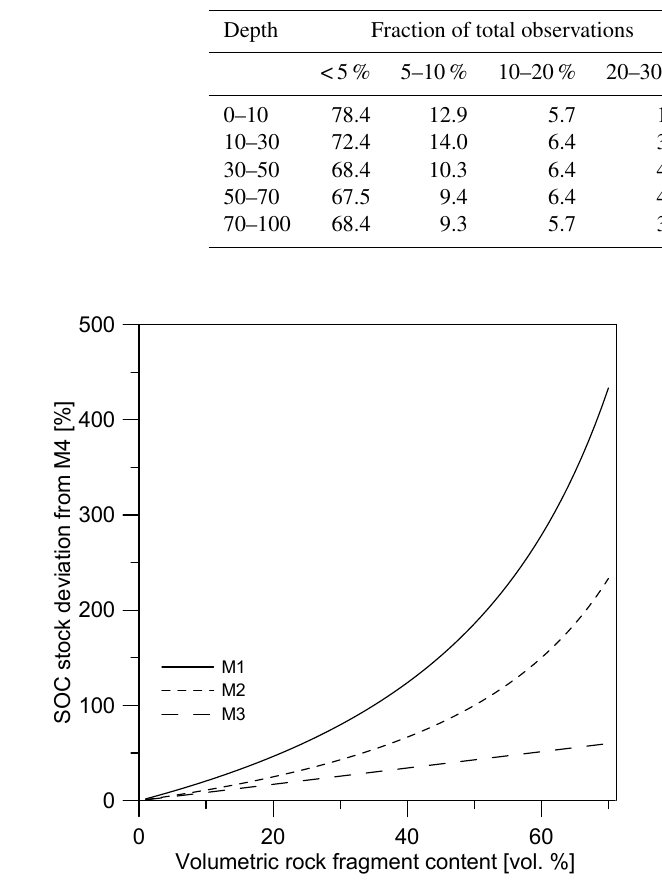
Figure 2. Systematic deviations in SOC stock from calculation method M4 for methods M1–M3 as a function of volumetric rock fragment content. Bulk density of the fine soil was set to 1.4gcm − 3 in this example.